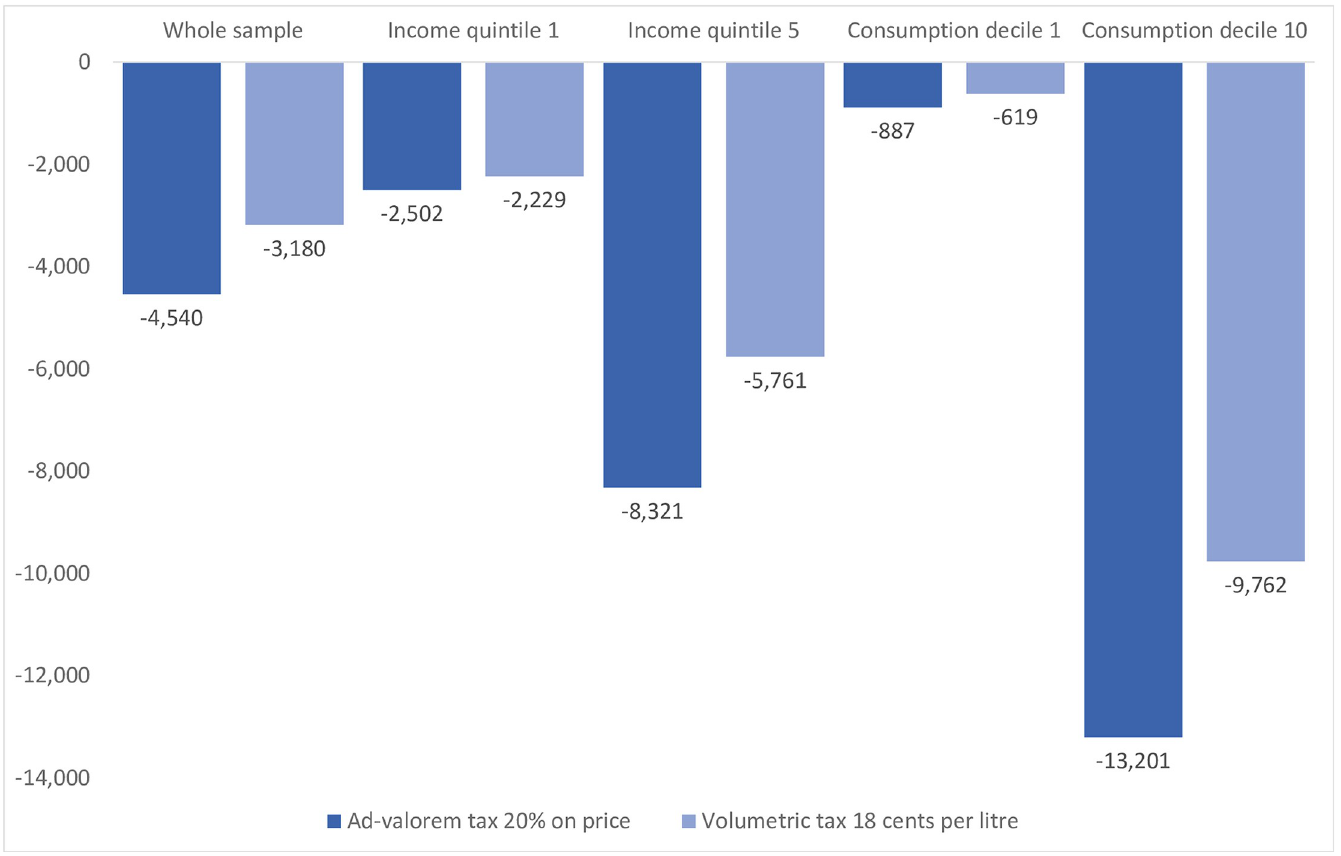
Fig 3. Policy impact simulation: Caloric change across income and consumption groups. Source: Own estimates based on Table 3 and S3–S6 Tables.